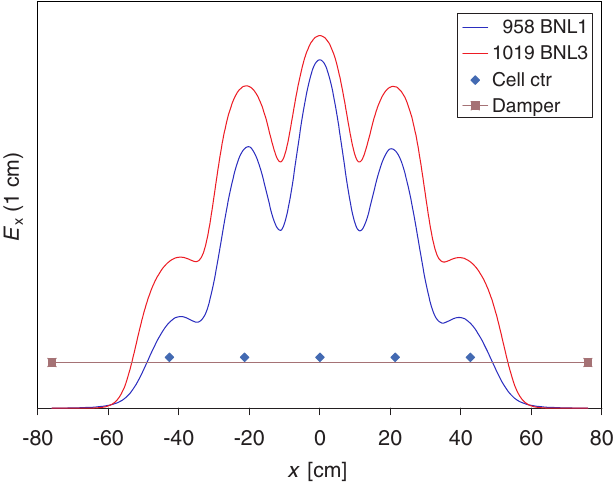
FIG. 16. Quasitrapped modes in the BNL1 and BNL3 cavities. The fields are plotted against the location of the cell centers and the damper.